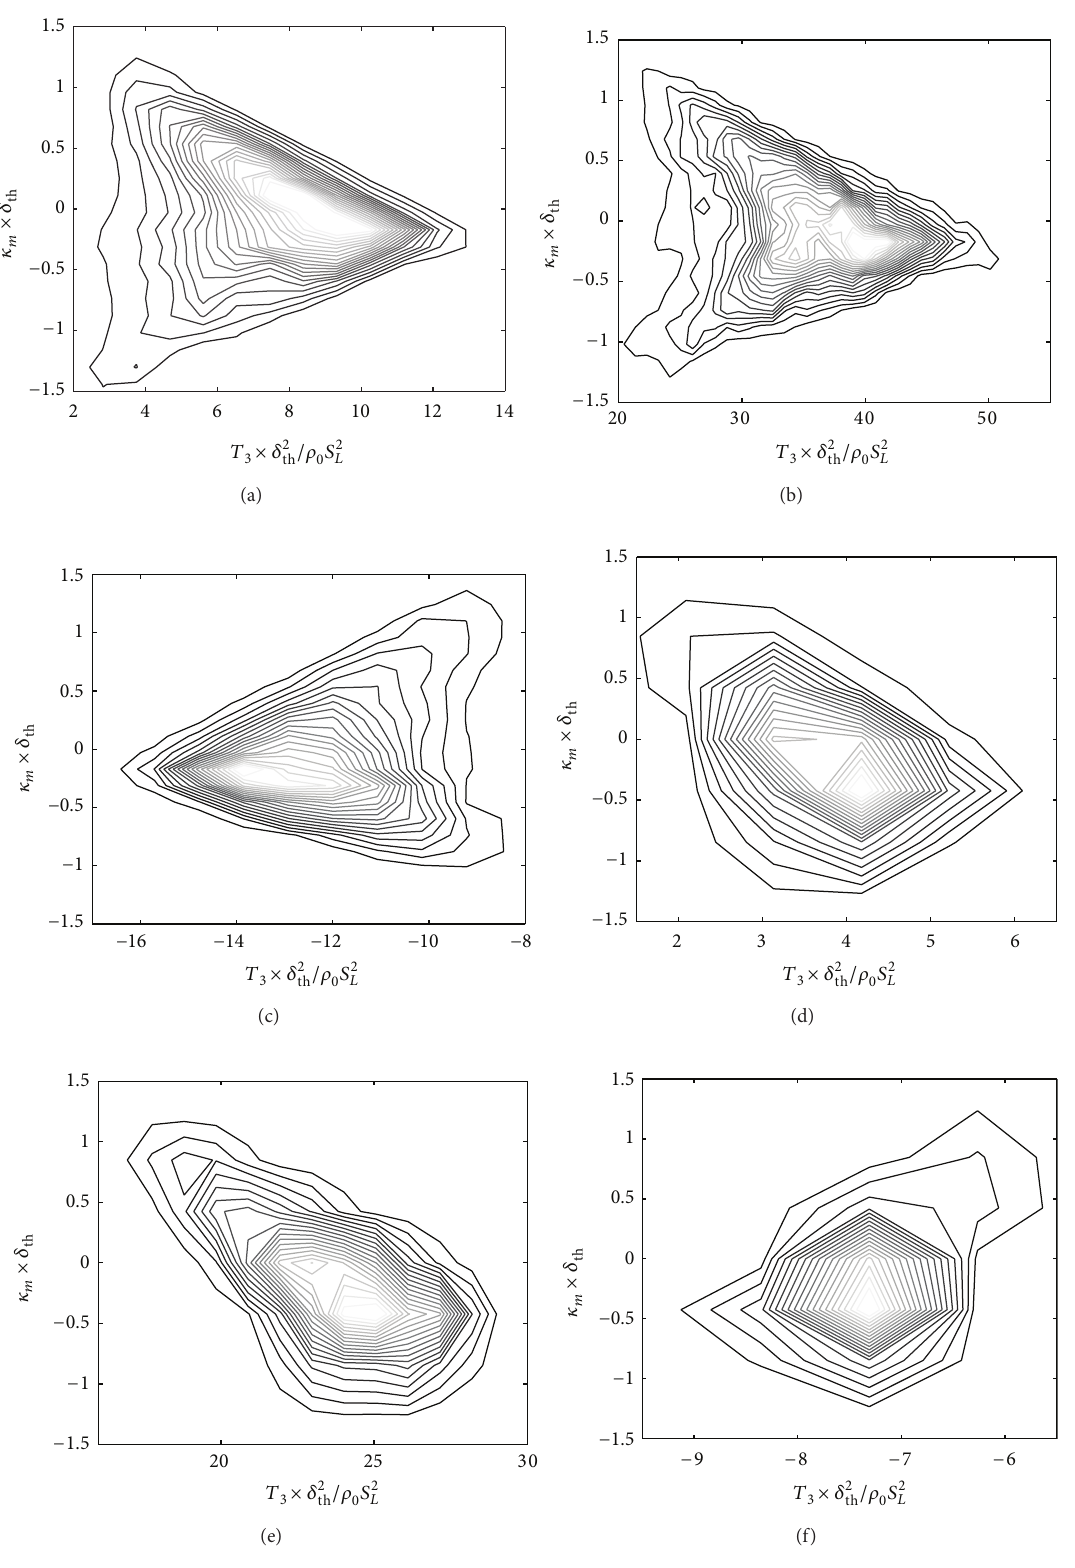
/𝜌 𝑆 2 0 𝐿 and normalised curvature th